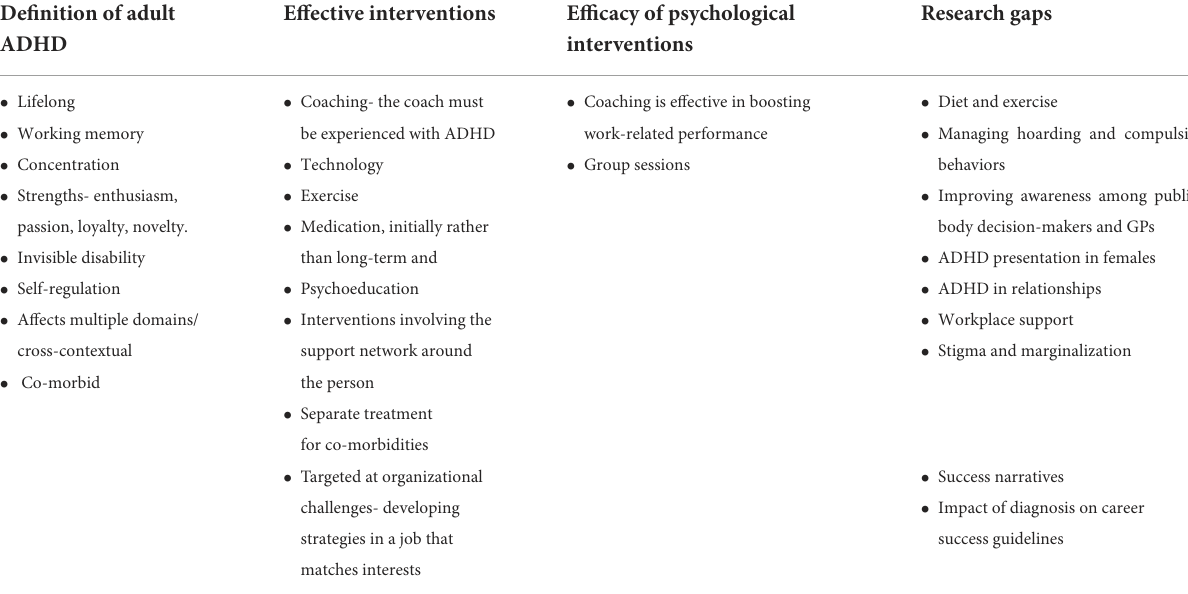
TABLE 1 Findings from the expert panel at the research question stage. Definition of